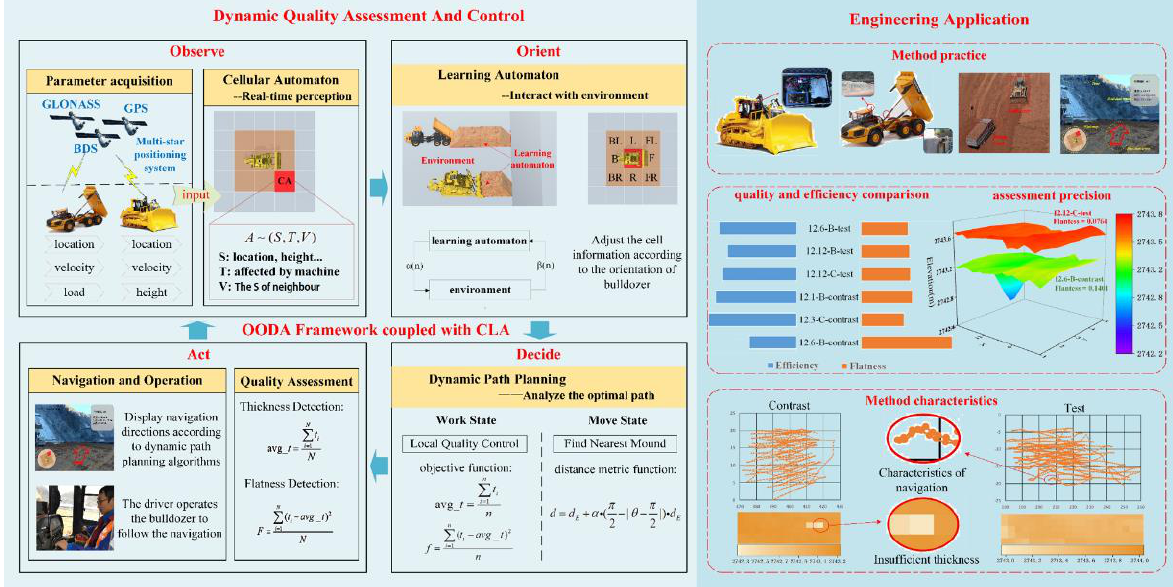
Figure 2. Composition and application of the proposed assessment and feedback control framework.